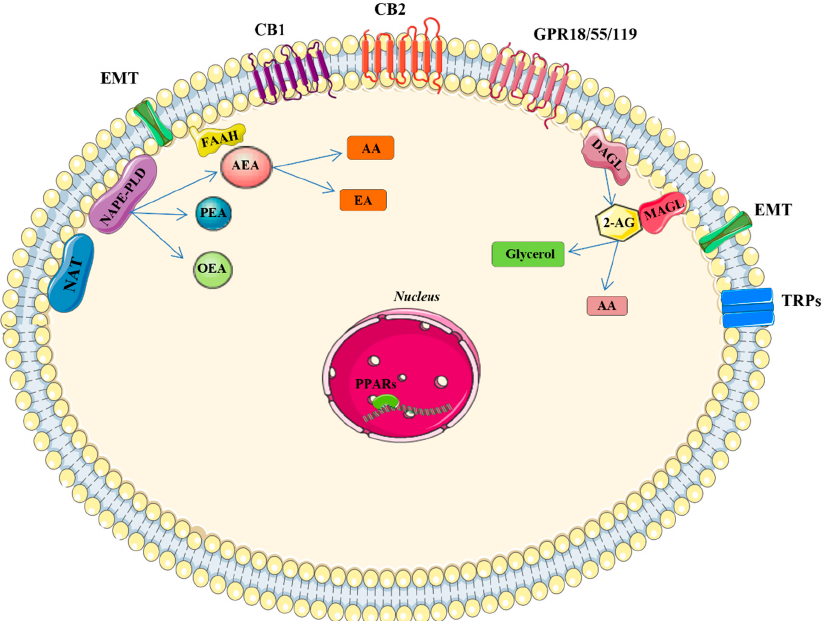
Figure 1. Main components of the endocannabinoid system (ECS). Biosynthesis of AEA and 2-AG take place on demand from membrane phospholipids by NAPE-PLD or calcium-dependent NAT and DAGL, respectively. The reuptake of endocannabinoids into cells occurs across the cell membrane by putative endocannabinoid protein transporters (EMT). FAAH is the main enzyme responsible for AEA degradation, while MAGL is the key enzyme in the hydrolysis of the 2-AG releasing arachidonic acid. Receptor targets of AEA and 2-AG on the plasma membrane are various: CB1, CB2, GPR18, GPR55, GPR119, and TRPs and in the nucleus PPARs. Abbreviations : EA: ethanolamine; AA: arachidonic acid; CB1: cannabinoid receptor 1, CB2: cannabinoid receptor 2, TRPs: transient receptor potential channels (V1-3, A1, and M8 types). GPRs: G-protein-coupled receptor (18, 55, and 119), and PPARs: peroxisome proliferator-activated nuclear receptors α , γ , or δ ; PEA: palmitoylethanolamide; OEA: oleoylethanolamide.